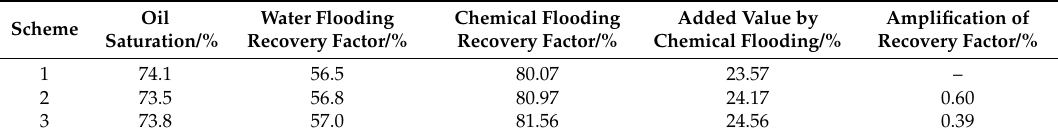
Table 7. Oil displacement results with different surfactant concentrations in the main slug.